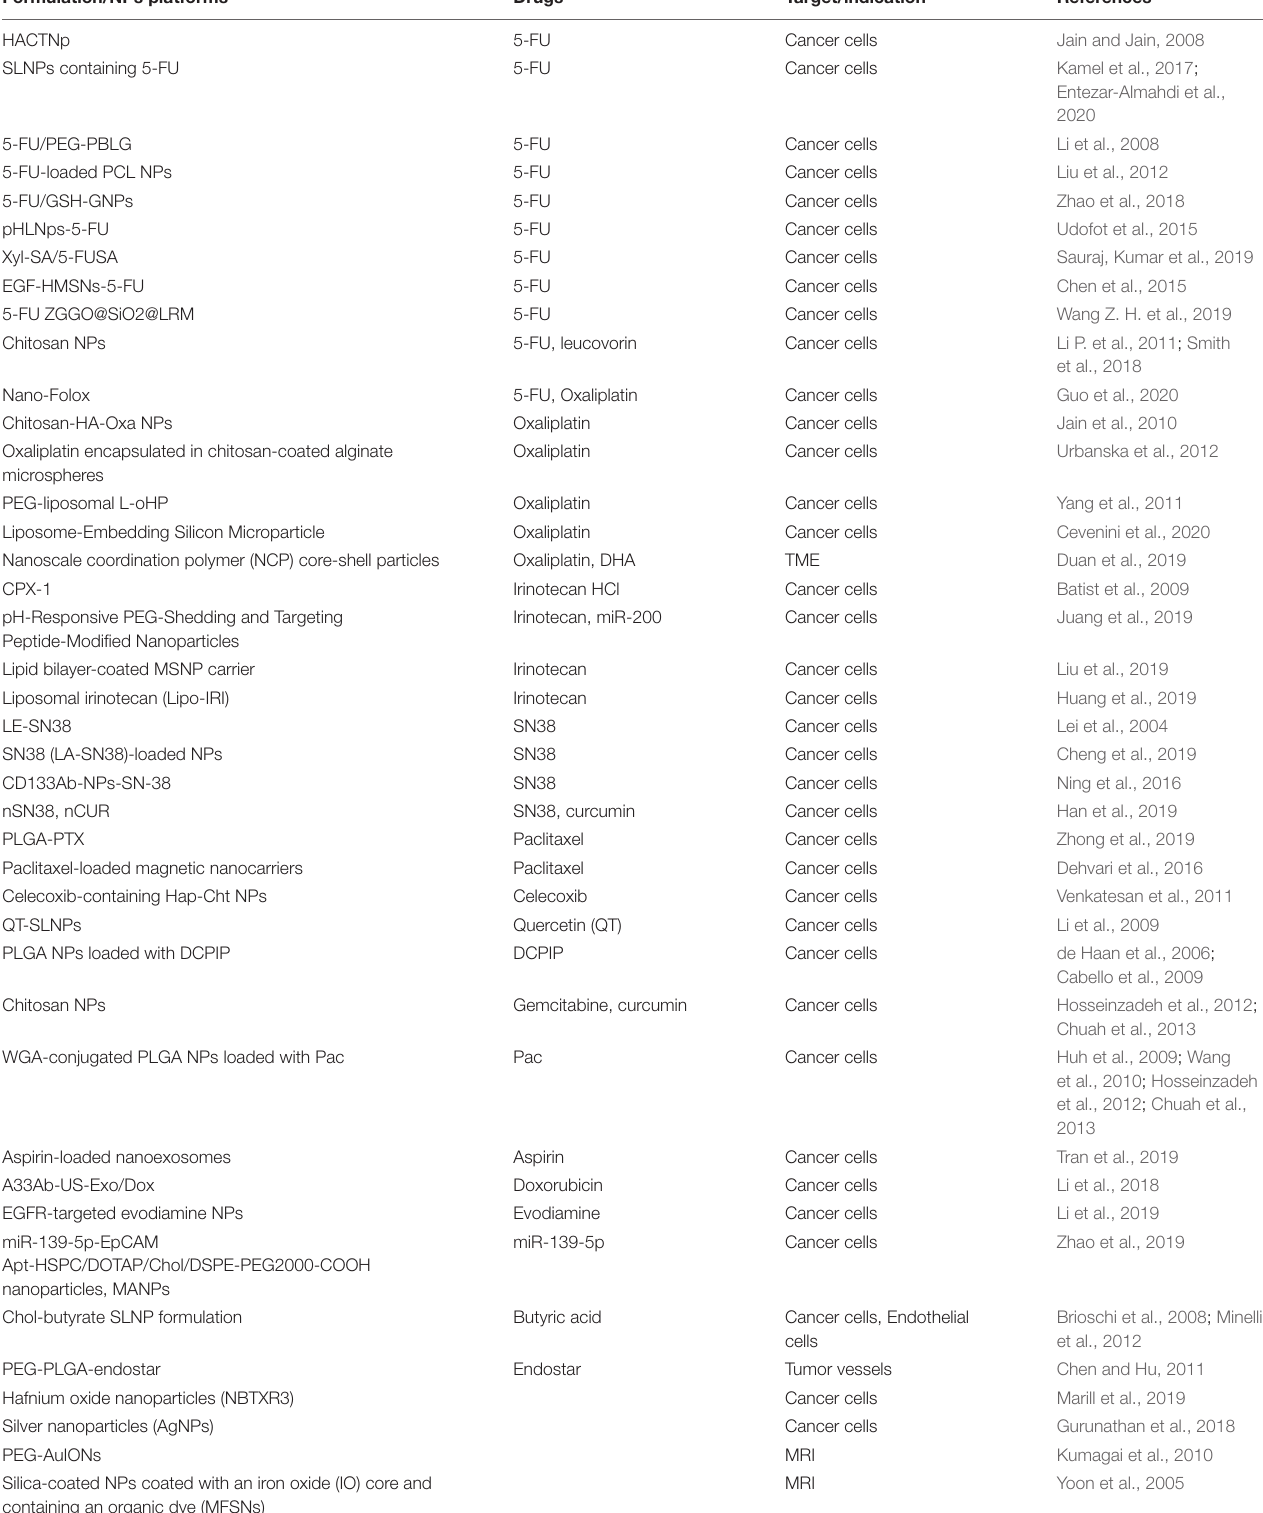
TABLE 1 | Summary of nanotechnology-based systems for